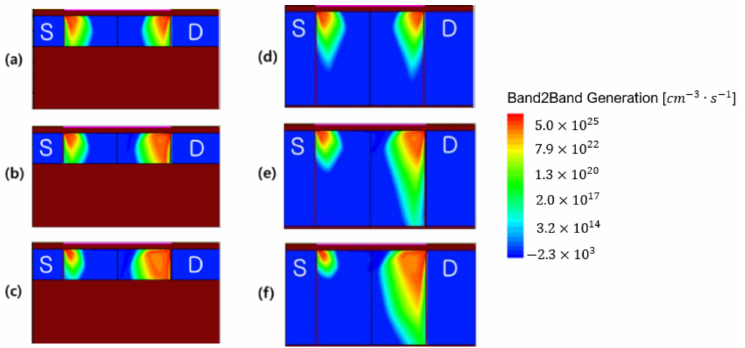
Figure 5. Band-to-band generation rate in Write“1” operation of ( a–c ) T Body 20 nm and ( d–f ) T Body 60 nm cells when the Write”1” drain voltage is ( a ), ( d ) 0.1 V, ( b ), ( e ) 1.0 V, and ( c ), ( f ) 2.0